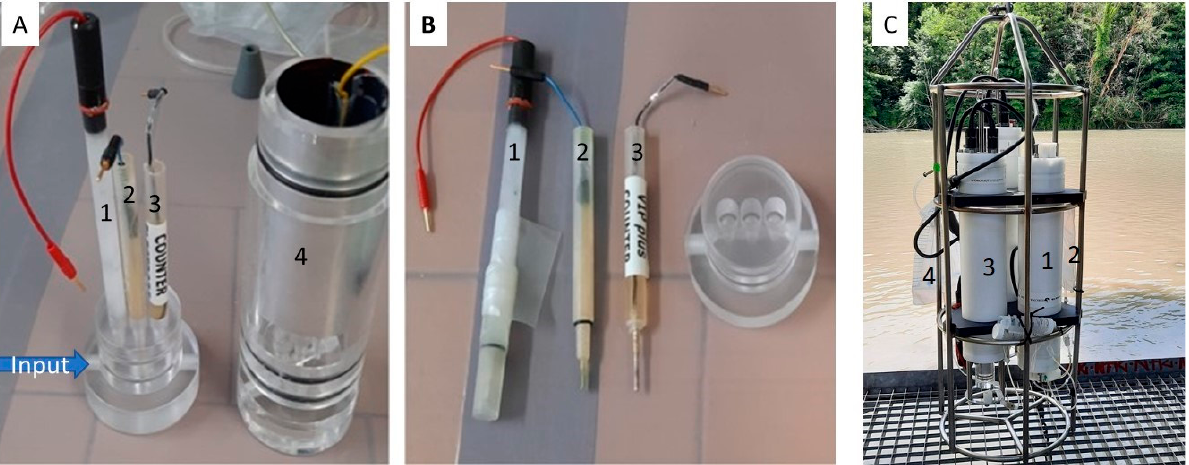
Figure 8. Picture of the ( A ) in ‐ house flowthrough plexiglass cell with the mini ‐ electrodes (1, 2 and 3) and the shielded Plexiglas holder (4) enabling incorporation of the flowthrough cell into the bottom of the VIP electronic housing; ( B ) mini ‐ reference electrode (1), the working microelectrode (2) and the mini ‐ counter electrode (3) and ( C ) the VIP system made of the peristaltic pump (1), the chirurgical bag containing the nioxime and buffer solutions (2); the voltametric probe with the in ‐ house flowthrough plexiglass cell at the bottom (3) and the chirurgical bag to collect the waste (4).